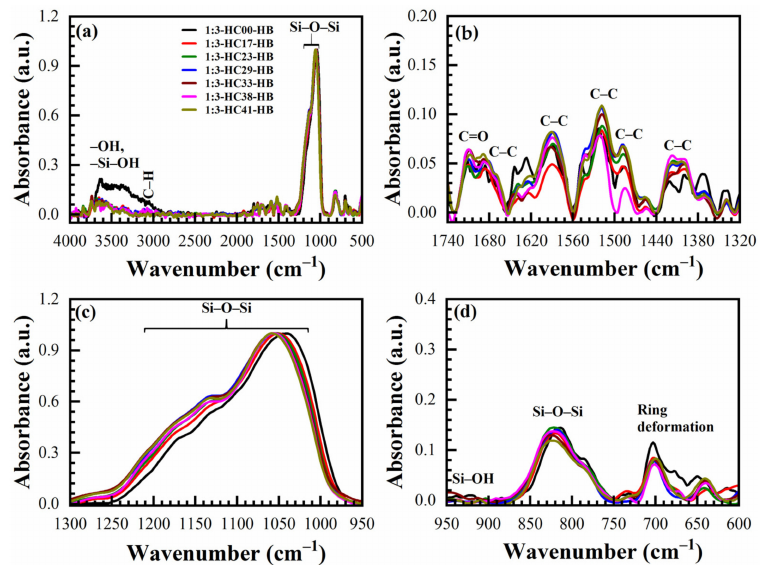
Figure 10. FTIR spectra of 1:3 ratio material films hard baked (HB) in the air (30 min) with different template loadings (0 to 41 wt%, films numbered from HC17 to HC41) where ( a ) is the full FTIR spectra and ( b – d ) are the parts of the full FTIR spectra.